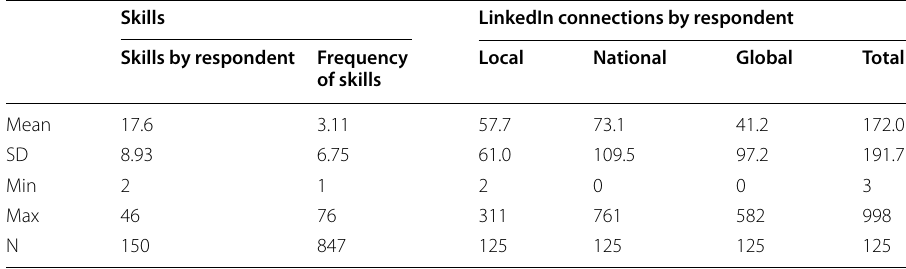
Table 1 Summary statistics of respondents’ skills and LinkedIn connections Skills LinkedIn connections by respondent Skills by respondent Frequency Local National Global of skills